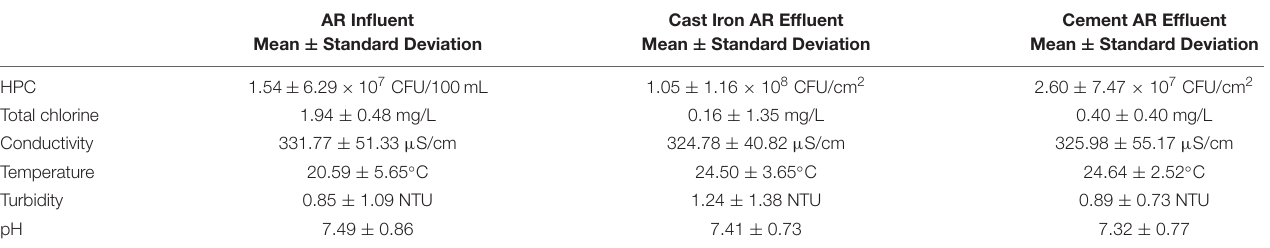
TABLE 1 | Summary of microbiological and physicochemical water quality in annular reactor (AR) influent (5-min data provided by local water utility over the study period) and effluent (analyzed weekly over the study period).